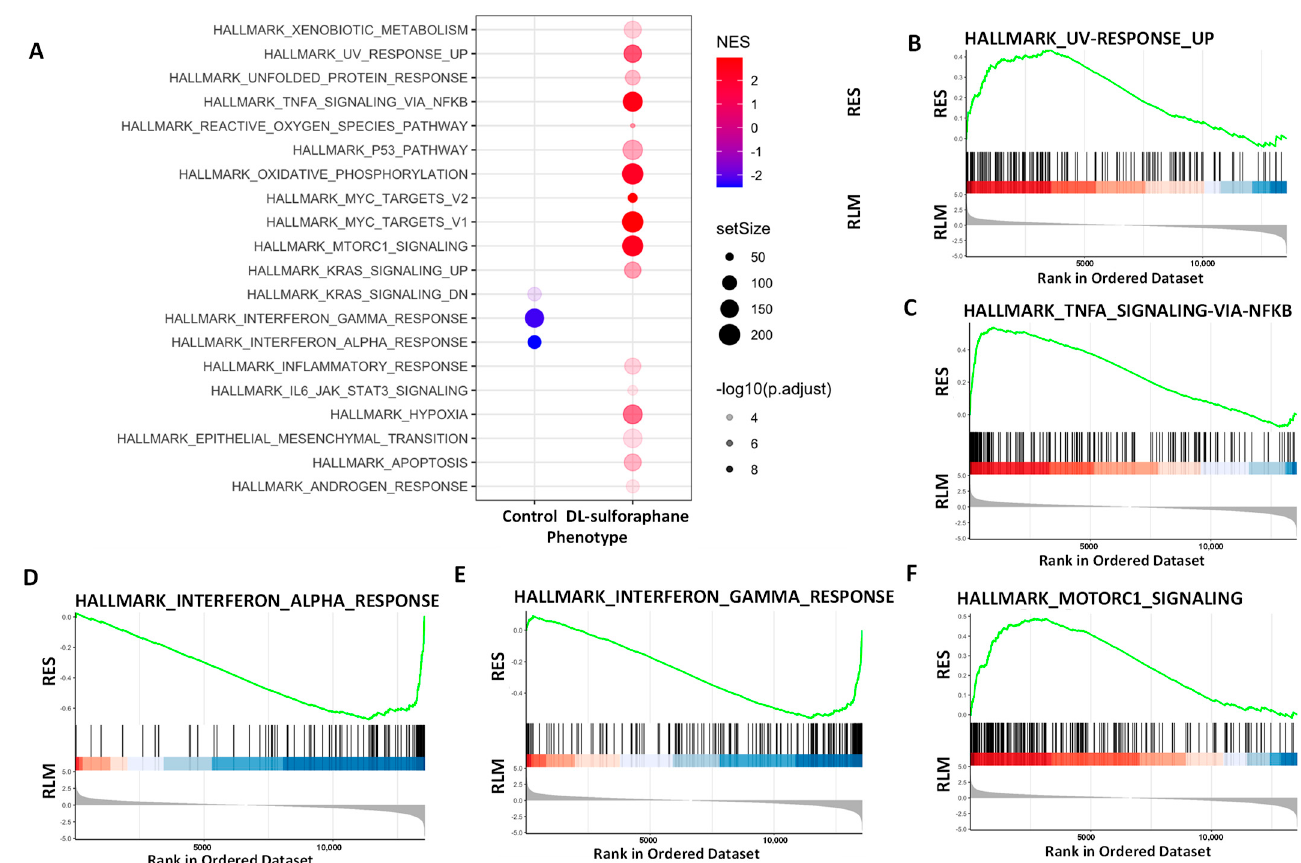
Figure 8. Hallmark analysis demonstrated the alteration of multiple pathways in SK-UT-1 cells in response to DL-sulforaphane treatment. ( A ) Functional pathways analysis identified significantly altered pathways in SK-UT-1 cells treated with DL-sulforaphane. Significantly enriched gene sets (DL-sulforaphane vs. control) from GSEA using Hallmark biological processes in MSigDB. Gene count and significance levels are shown by the size and color of each circle, respectively. Pathways analysis revealed that several gene sets associated with UV response ( B ), TNFa via NFkB ( C ), Interferon-alpha ( D ), Interferon-gamma ( E ), and MTORC1 ( F )